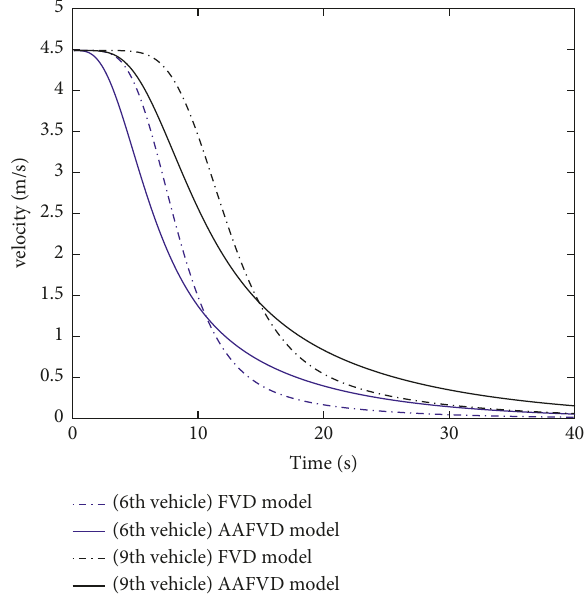
Figure 4: Comparison of two vehicles’ velocity during the arrival process simulated by the FVD and IH